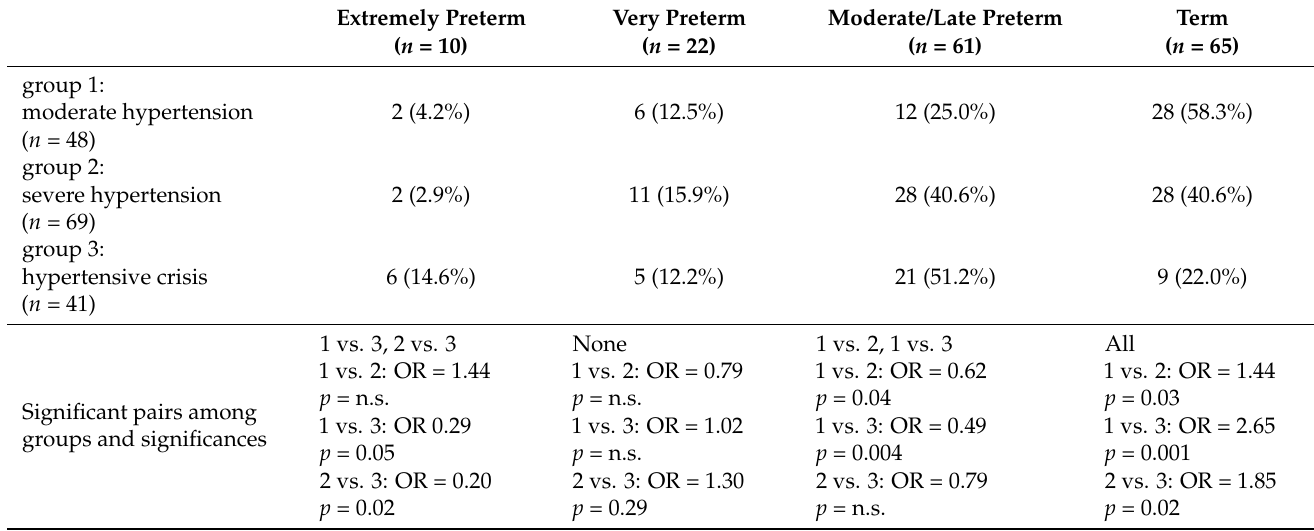
Table 3. Correlation of maternal blood pressure levels and gestational age at delivery. We used common classifications for subdivision into blood pressure groups as well as gestational age at delivery [10,16,18,20]. The proportion of patients from the respective gestational age group in relation to the blood pressure group is expressed in percentages (e.g., 2/48 (4.2%) women blood pressure groups between different gestational ages was compared and statistical differences were